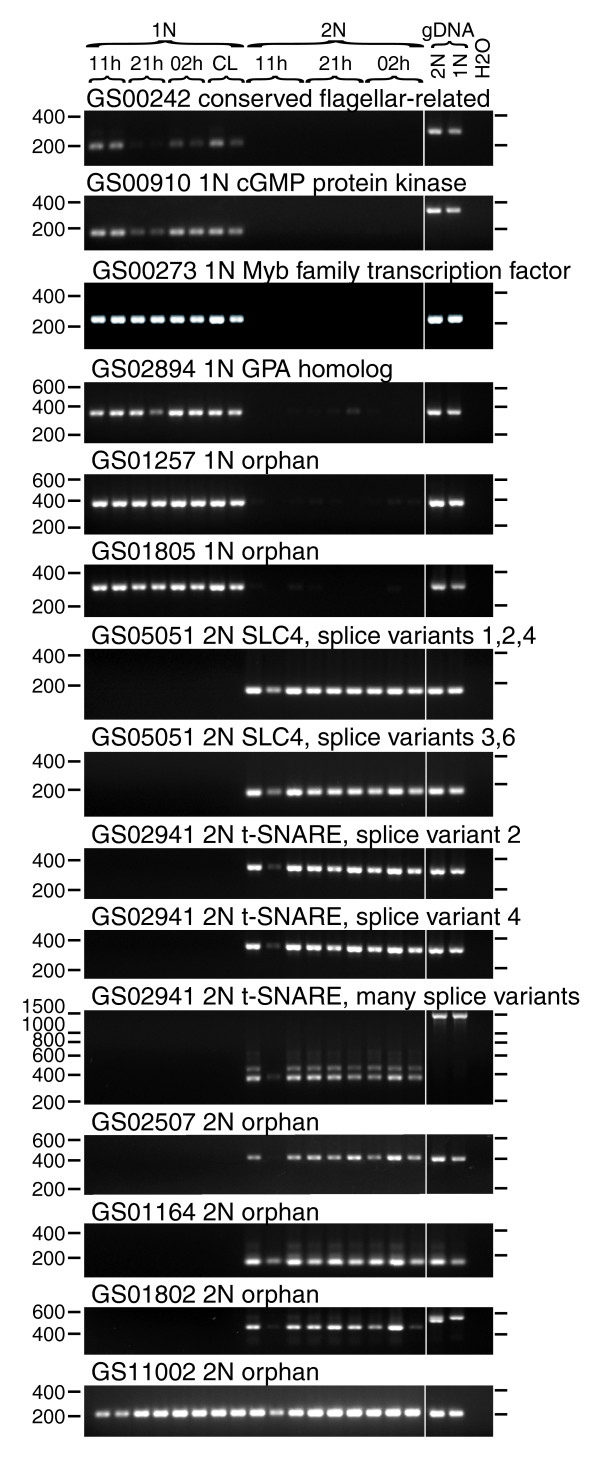
RT-PCR tests of expression patterns of selected genes chosen by digital subtraction. RT- control reactions prepared from the same RNA were run for six of the PCRs shown here and no contaminating genomic DNA (gDNA) was ever found. For clarity, RT- control reactions run simultaneously have been cut out here. Positions of molecular weight markers on each side of the gel are shown. The sample identifiers are listed for each lane at the top of the gel (as for Figure 7).